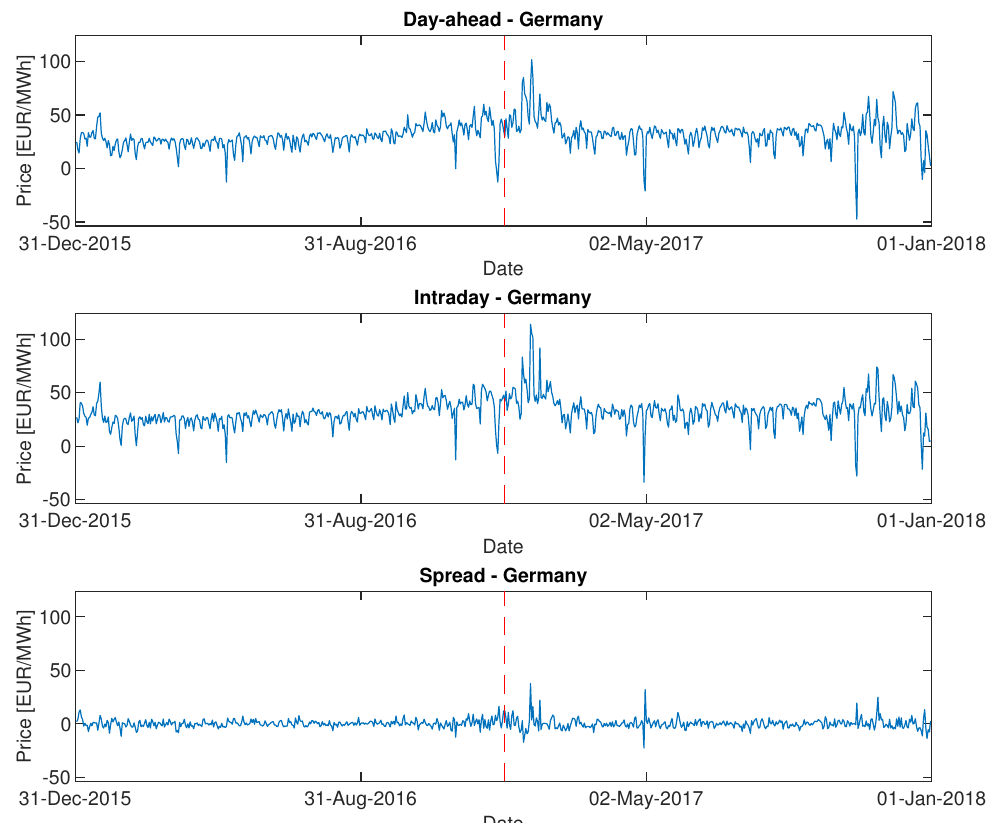
Figure 2. Day-ahead prices, intraday prices, and price spread for Germany with estimation and validation